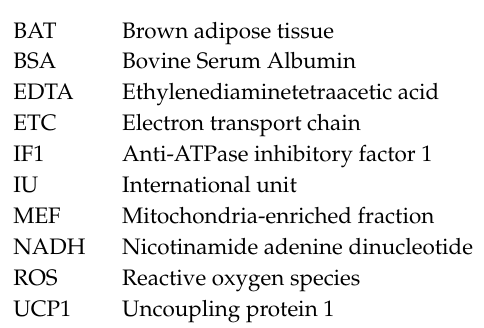
Figure S1: Ponceau red staining was used to show no di ff erences in total protein quantities. Author Contributions: Conceived and designed the experiments: I.G. and A.K. (Aleksandra Korac); performed the experiments: I.G., A.K. (Andjelika Kalezic), A.J., B.K., and A.K. (Aleksandra Korac); analyzed the data: